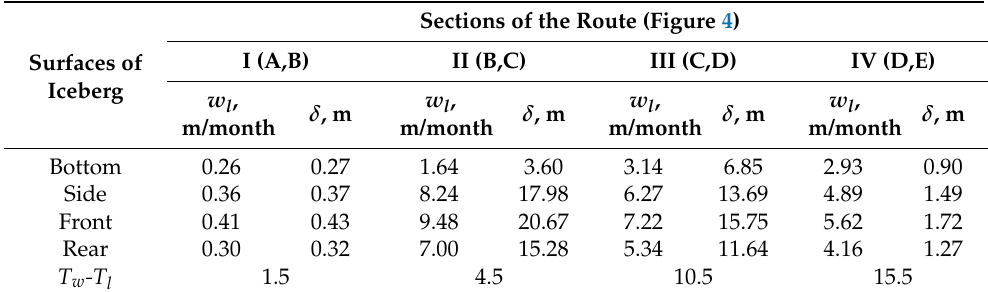
Table 6. Calculated values of ice melting speed and thickness of molten layer for the respective surfaces and individual sections of the route (own elaboration).